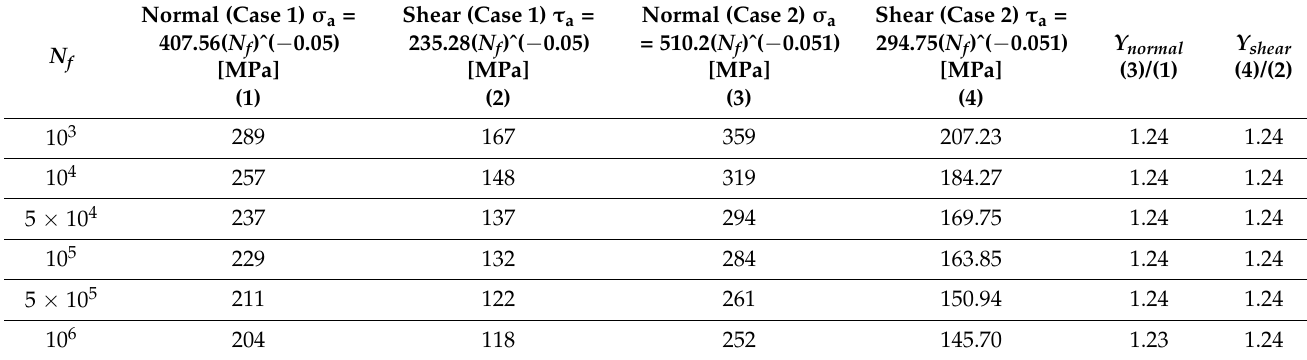
Table 5. Y results for case 1 vs. case 2—AISI303.